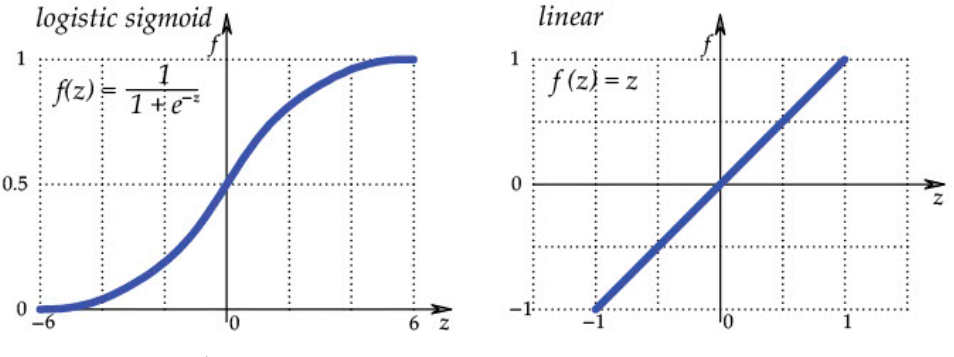
Figure 1. Activation functions.